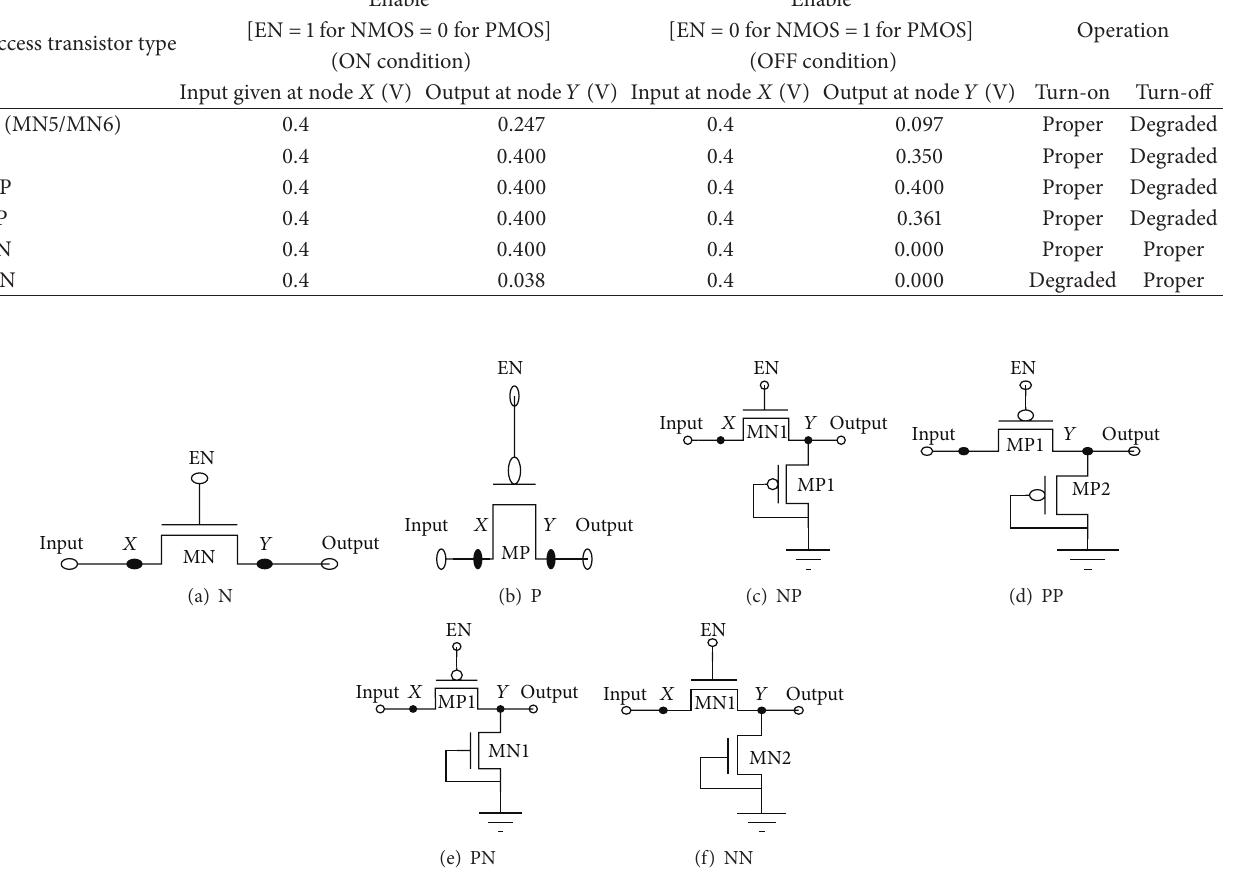
Figure 3: Schematics of access